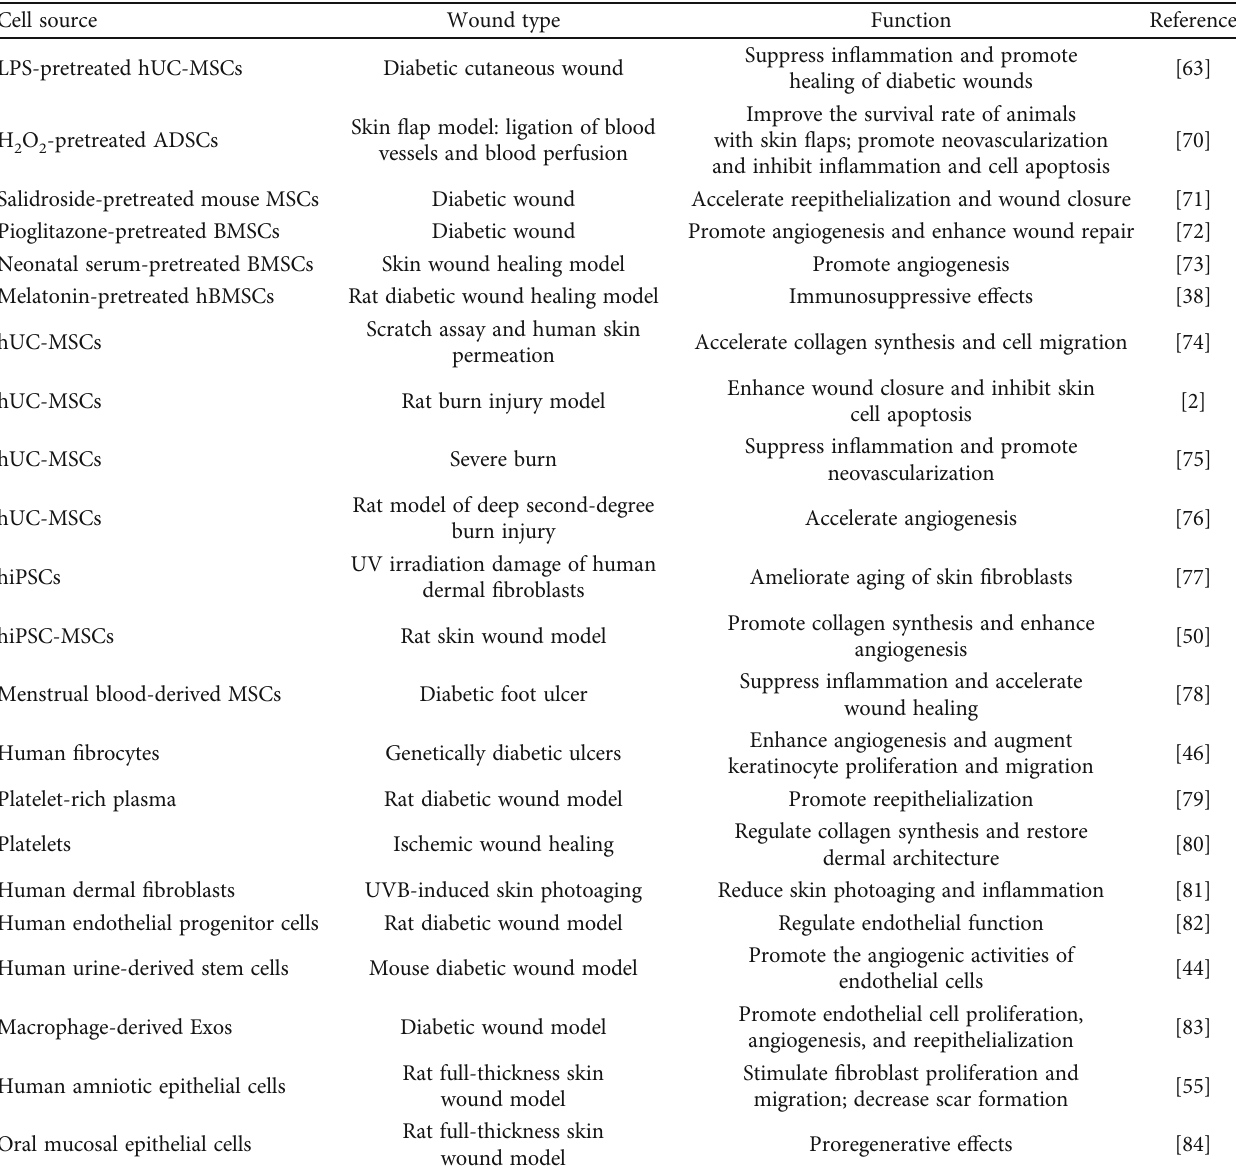
Table 1: Overview of research on the use of CDNs for wound